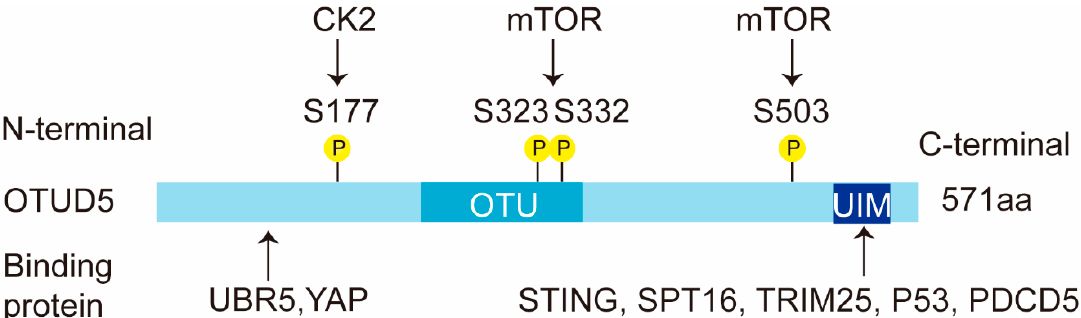
Figure 1. Schematic representation of the OTUD5 domains. OTUD5 has two structural domains, an N-terminal OTU domain and a C-terminal UIM domain. The human OTUD5 transcript is 571 aa. OTUD5 interacts with multiple proteins, such as YAP, SPT16, TRIM25, TP53 and PDCD5. This figure shows the diverse binding fragments of these proteins. OTUD5 is phosphorylated by kinase CK2 and mTOR. The phosphorylation sites are shown in the fi gure. P: phosphorylation.